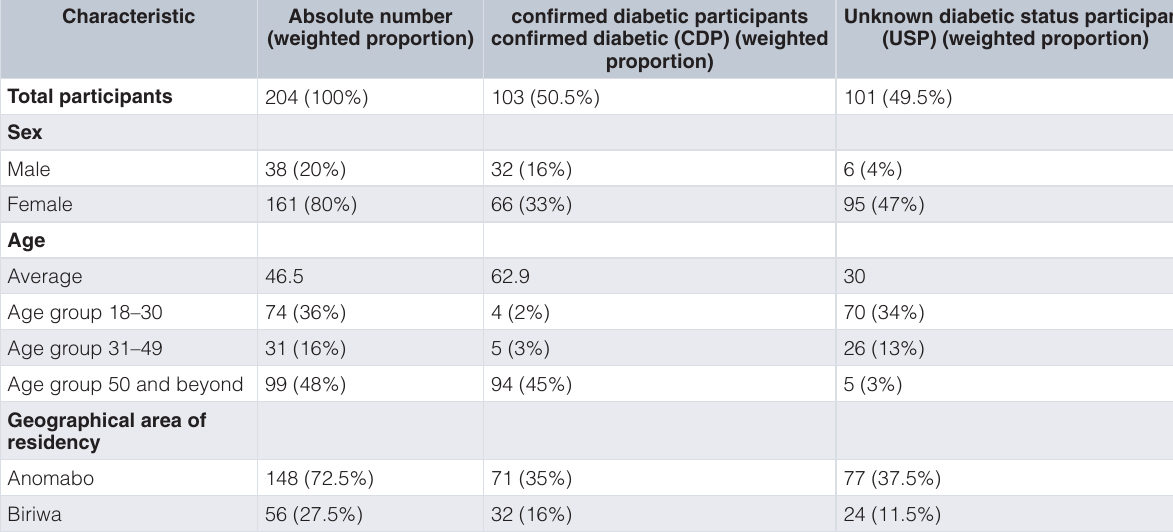
Table 1. Summary of the main demographic